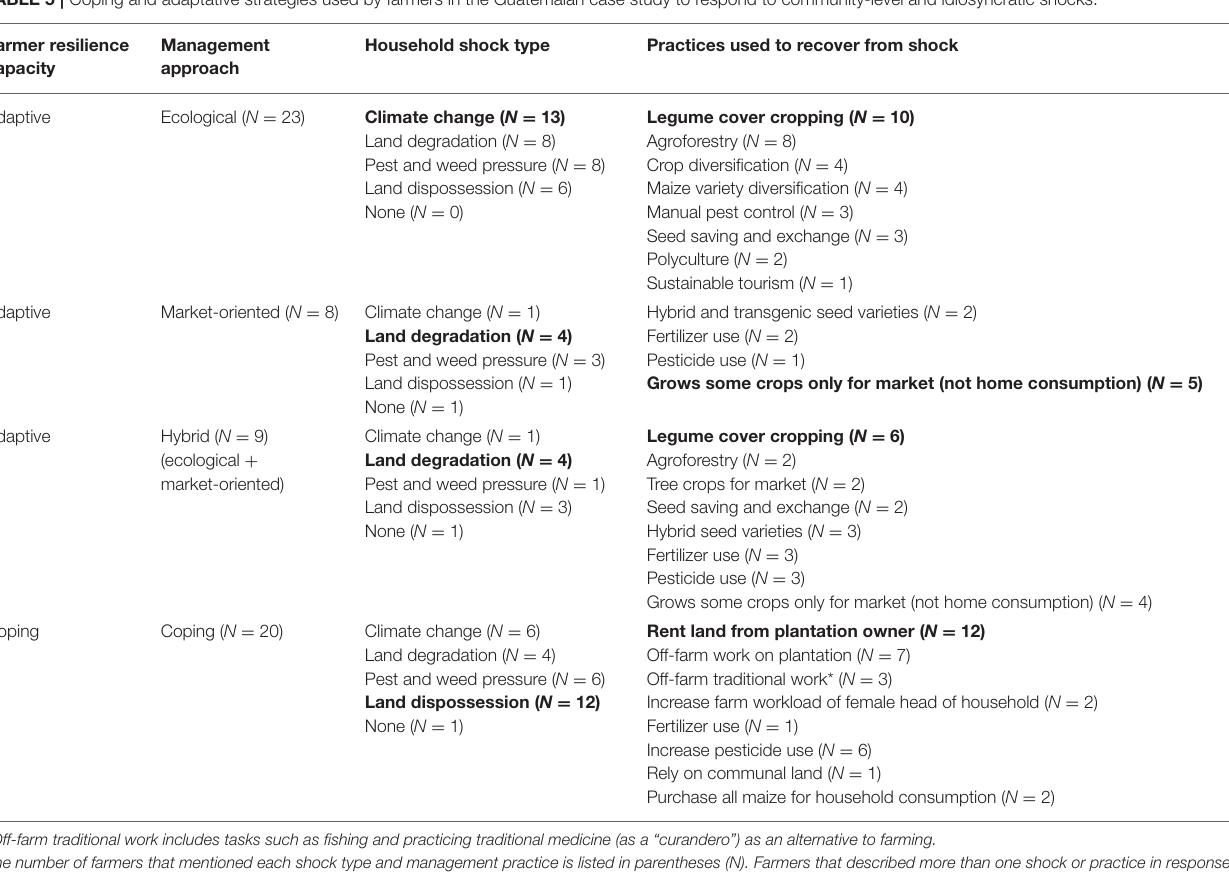
Frontiers in Sustainable Food Systems |